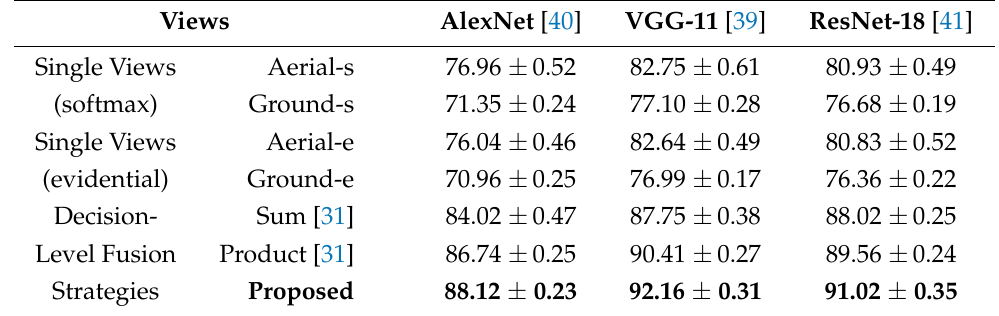
Table 3. Classification accuracy (%) ± STD of single views and after decision-level fusion on AiRound.